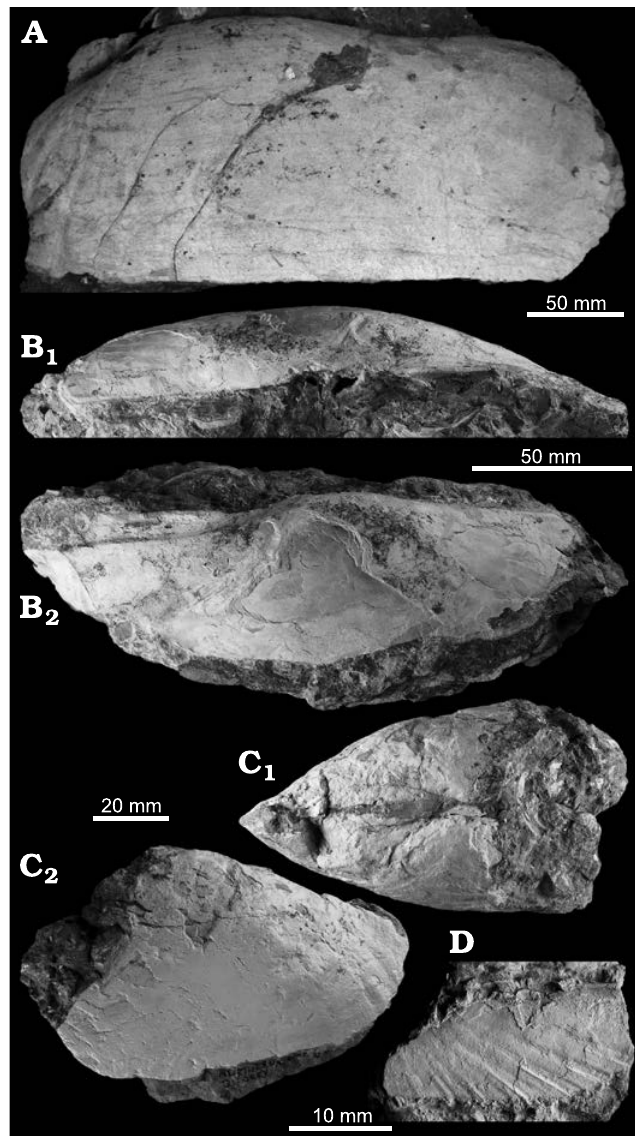
Fig. 2. Solemyid bivalves from Upper Miocene seep deposits of the Amlang Formation in Pangasinan province, Luzon, Philippines. A – C . Acharax aff. bartschii (Dall, 1908). A . NIGSPAL-003, large RV, view on outer side of shell. B . NRM Mo 192667, large RV in dorsal view (B 1 ) and view on outer side of LV (B 2 ). C . NIGSPAL-033, large articulated specimen in dorsal view (C 1 ) and view on outer side of LV (C 2 ); note that the specimen is gap- ing so in dorsal view it appears wider than it is. D . Acharax sp. with only the anterior portion preserved (NRM Mo